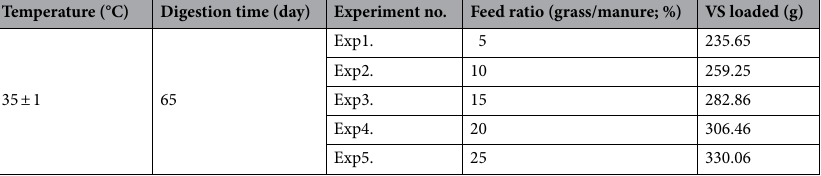
Table 1. Operational parameters.